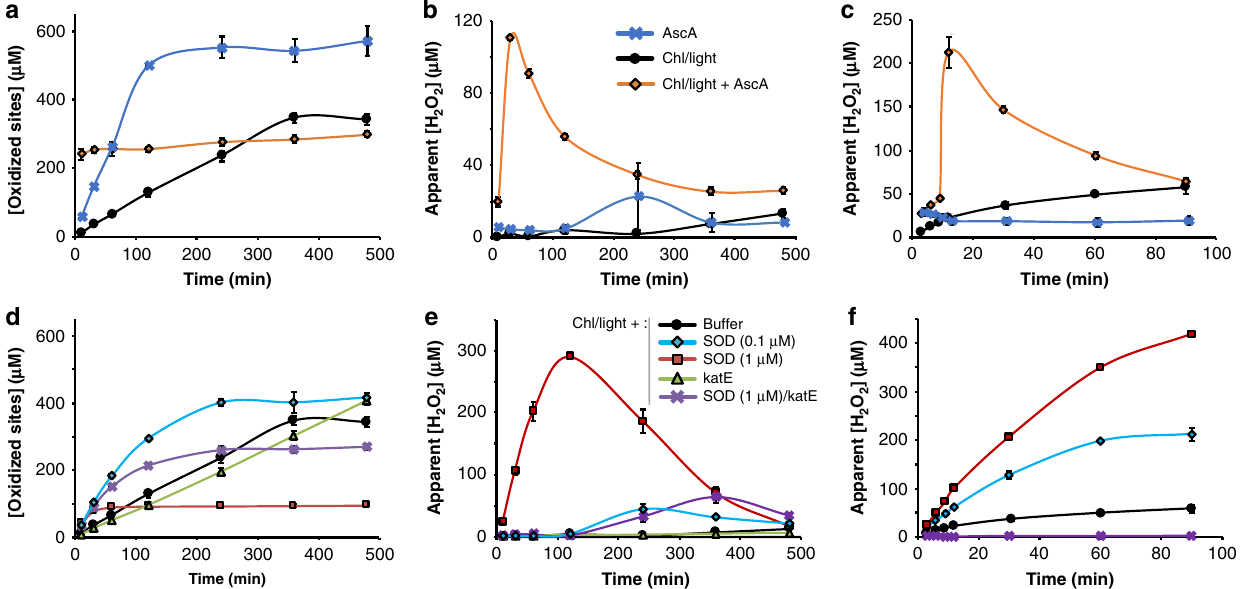
Fig. 2 Probing the role of reactive oxygen species in the light/Chl/LPMO system. The graphs show time-courses for the release of aldonic acid products ( a , d ) and apparent H 2 O 2 levels ( b , e ) in LPMO ( Sc AA10C, 0.5 µ M) reactions with substrate (Avicel, 10 g L − 1 ), as well as apparent H 2 O 2 levels in equivalent reactions lacking the LPMO ( c , f ). The top ( a – c ) panels show results for reactions fueled by Chl (500 µ M) exposed to visible light ( I = 25% I max , approx. 42 W cm − 2 ) in the absence or presence of AscA (1 mM), or fueled by 1 mM AscA alone, in the dark. d – f Effect of SOD (0.1 or 1 µ M) and catalase, katE (10 µ g mL − 1 ), on the reaction fueled by Chl/light. The legend code displayed in b applies also to a , c ; likewise the legend code in e applies also to d , f . All reactions were carried out in sodium phosphate buffer (50 mM, pH 7.0) at 40 °C, under magnetic stirring. Before product quanti fi cation, solubilized cello-oligosaccharides were hydrolyzed by Tf Cel5A, to convert the LPMO products to a mixture of only two oxidized products with a degree of polymerization of 2 and 3 [GlcGlc1A, (Glc) 2 Glc1A], the amounts of which were summed up to yield the concentration of oxidized sites. It must be noted that the LPMO and the redox-active compounds in each of the reactions can engage in multiple side reactions, such as oxidation of AscA by H 2 O 2 or generation of H 2 O 2 by the LPMO, which explains why H 2 O 2 levels are not stable and referred to as apparent. Error bars show ± s.d. ( n = 3, independent experiments). Source data are provided as a Source Data fi